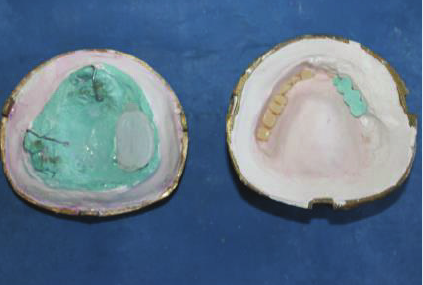
Figure 9: Adaptation of bulb template in defect area before